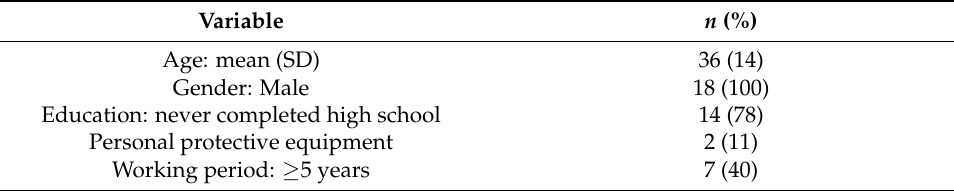
Table 1. Demographic